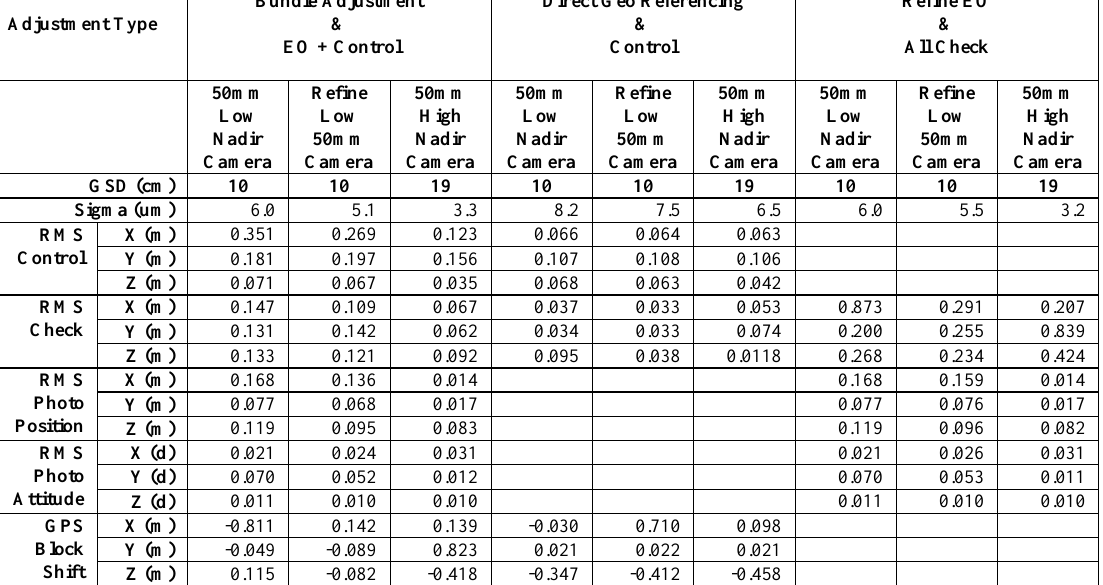
Table 11. Bundle Adjustments Results of the 50mm Configuration